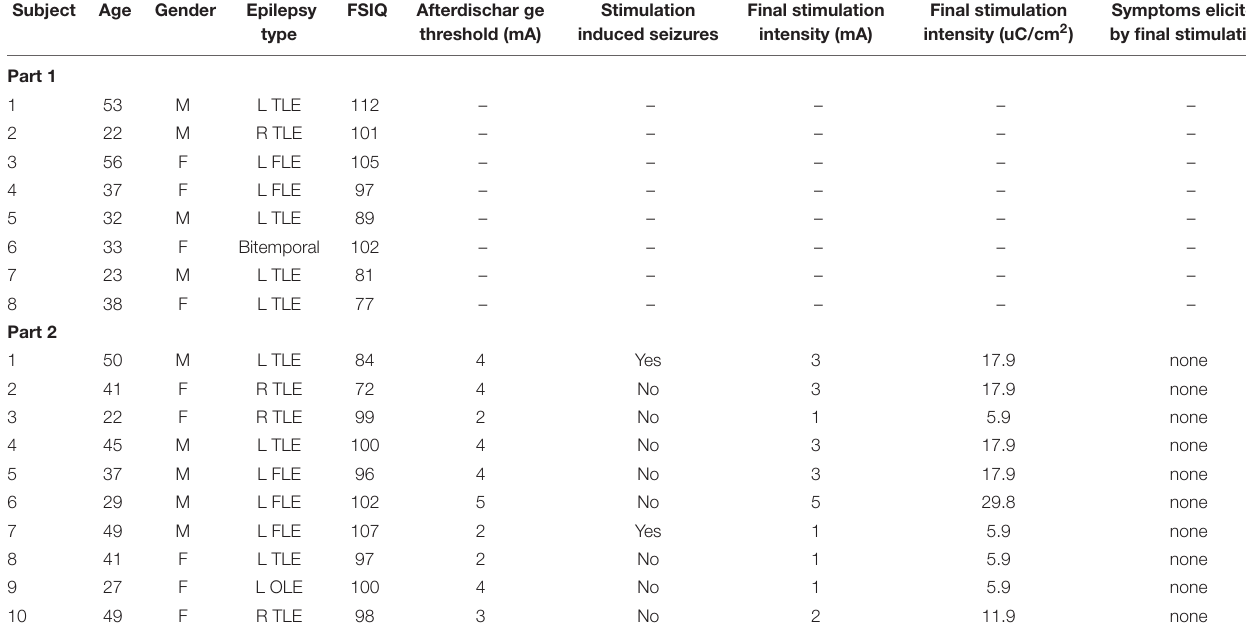
TABLE 1 | Demographics and afterdischarge threshold testing.